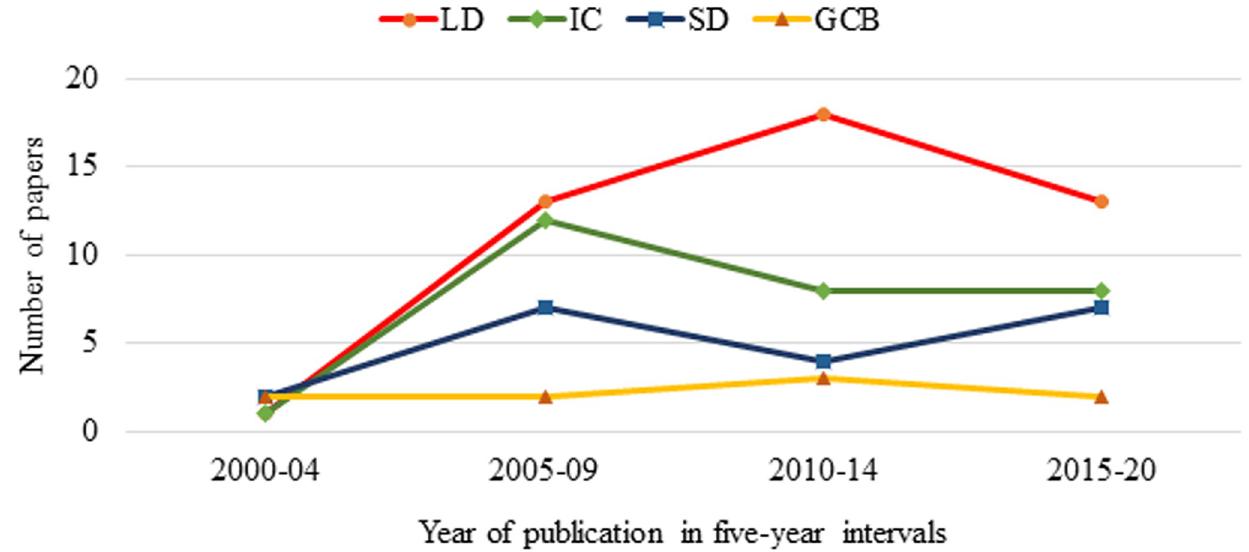
Fig 3. Research aims plotted over 5-year bins from 2000–2020. The four aims plotted were lameness detection (LD), intervention/comparison (IC), system development (SD), gait/claw biomechanics (GCB).